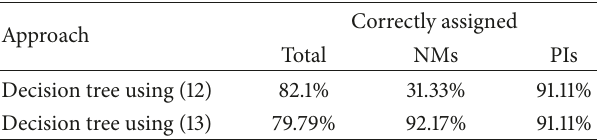
Table 13: Decision tree percentage classification results using (12) and (13).